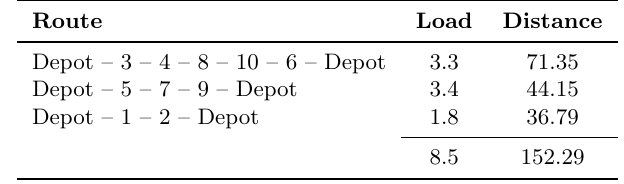
Table 6: Better results for the illustrative